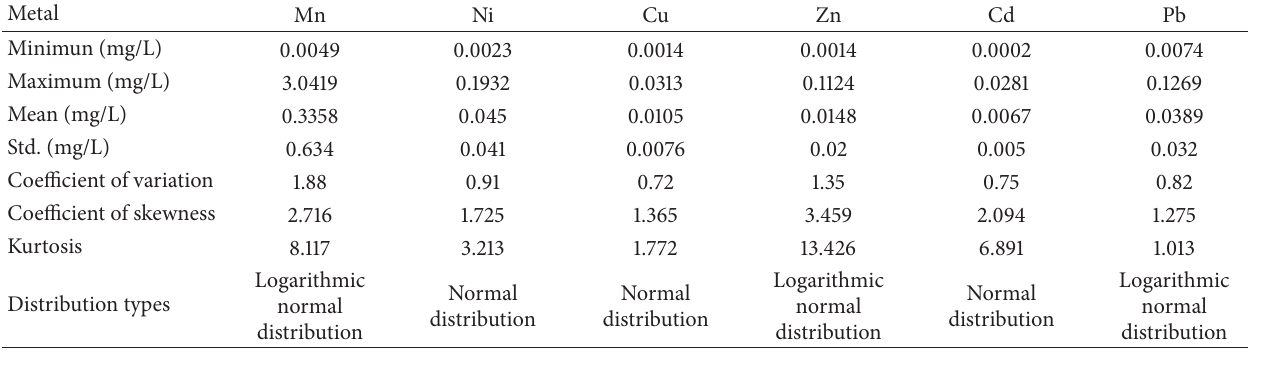
Table 1: Statistical characteristics of the metals concentrations.